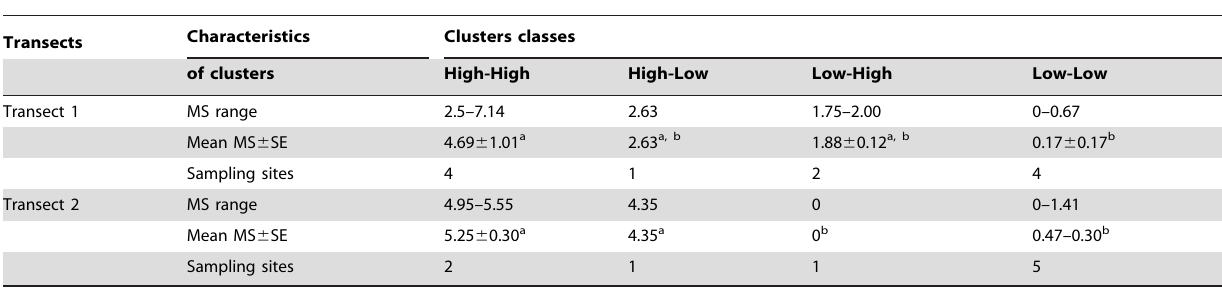
Table 3. Characteristics of clusters